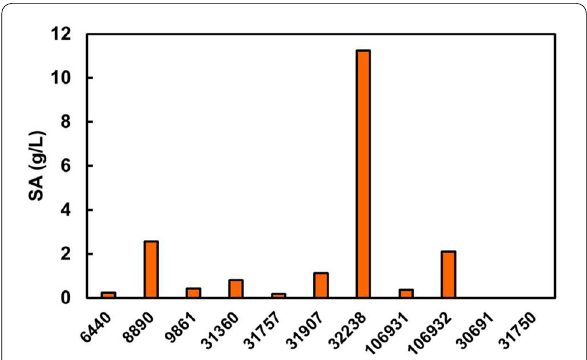
Fig. 1 Screening for an spiculisporic acid‑producing fungus from Talaromyces species. Cultivation was performed in a baffle flask for 7 days. The medium volume was 100 mL, containing 100 g/L glucose. The culture conditions were pH 3.0 and a temperature of 28